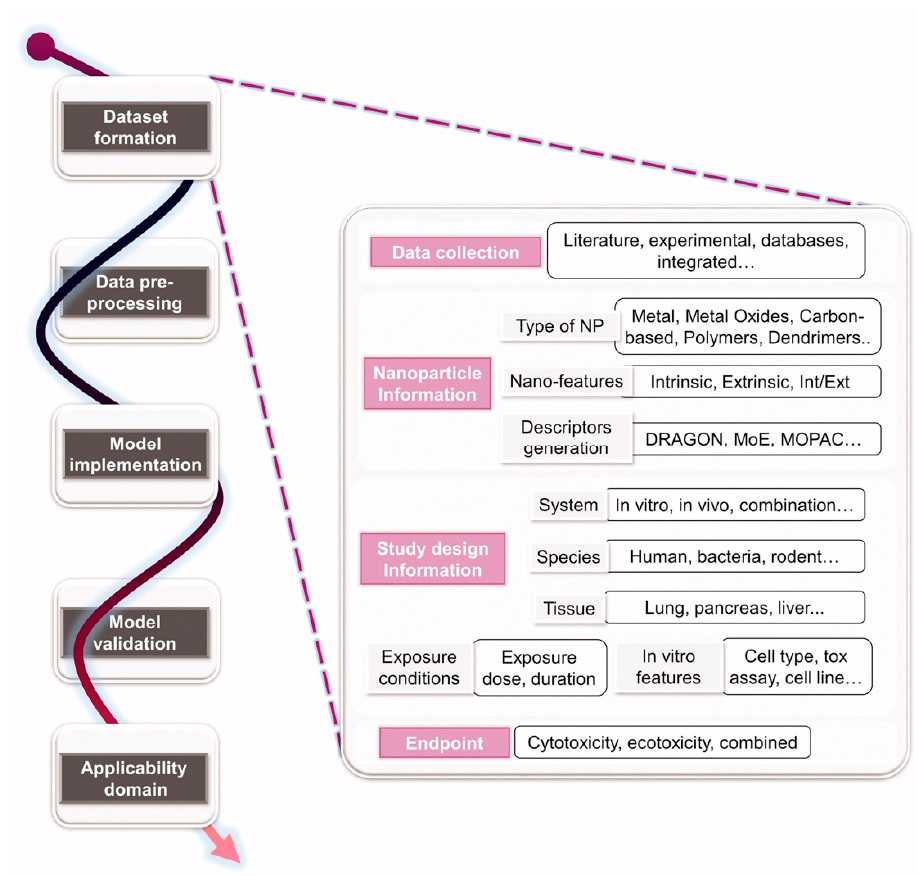
Figure 5. A summarized general roadmap for implementing a model in the field of nanotoxicology. The roadmap can be divided into five main parts: dataset formation review, data pre-processing, model implementation, model validation, applicability domain. Reproduced from reference [219]. Copyright Taylor and Francis, 2020.